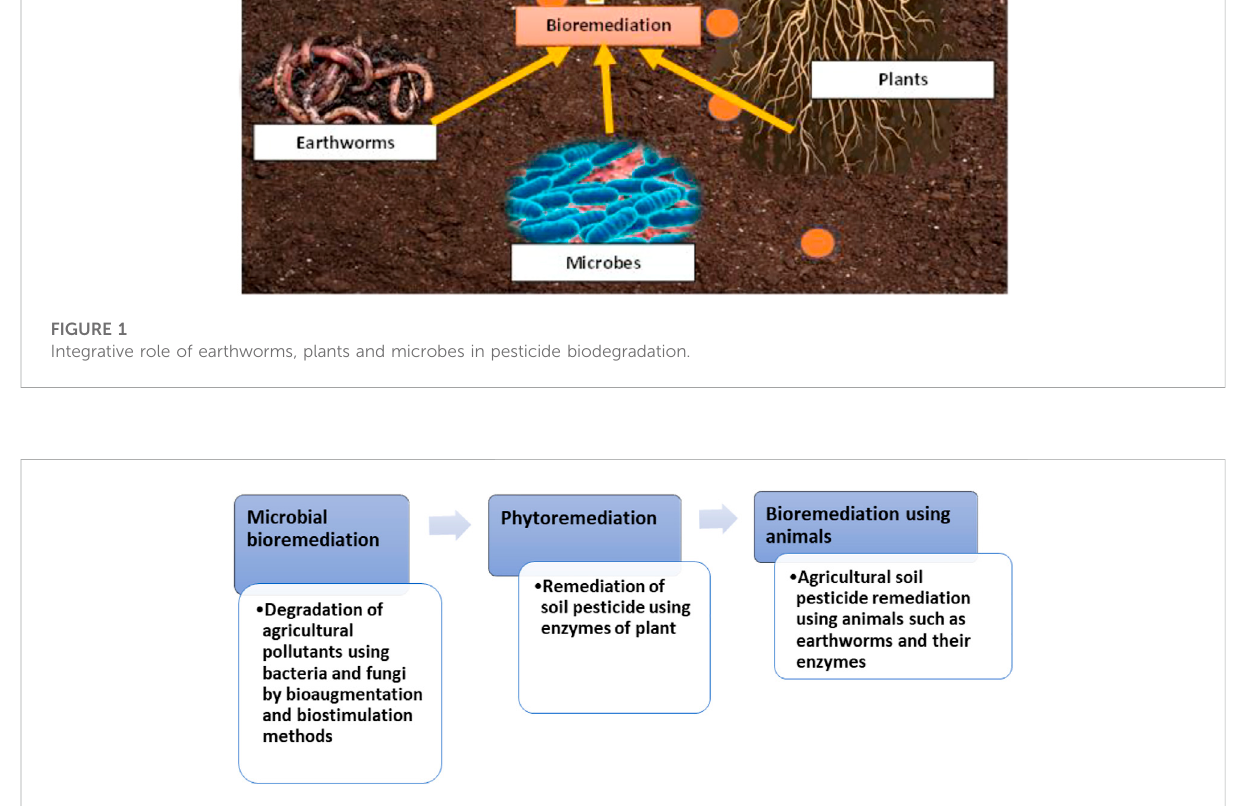
FIGURE 2 Bioremediation technologies for pesticide-contaminated agricultural